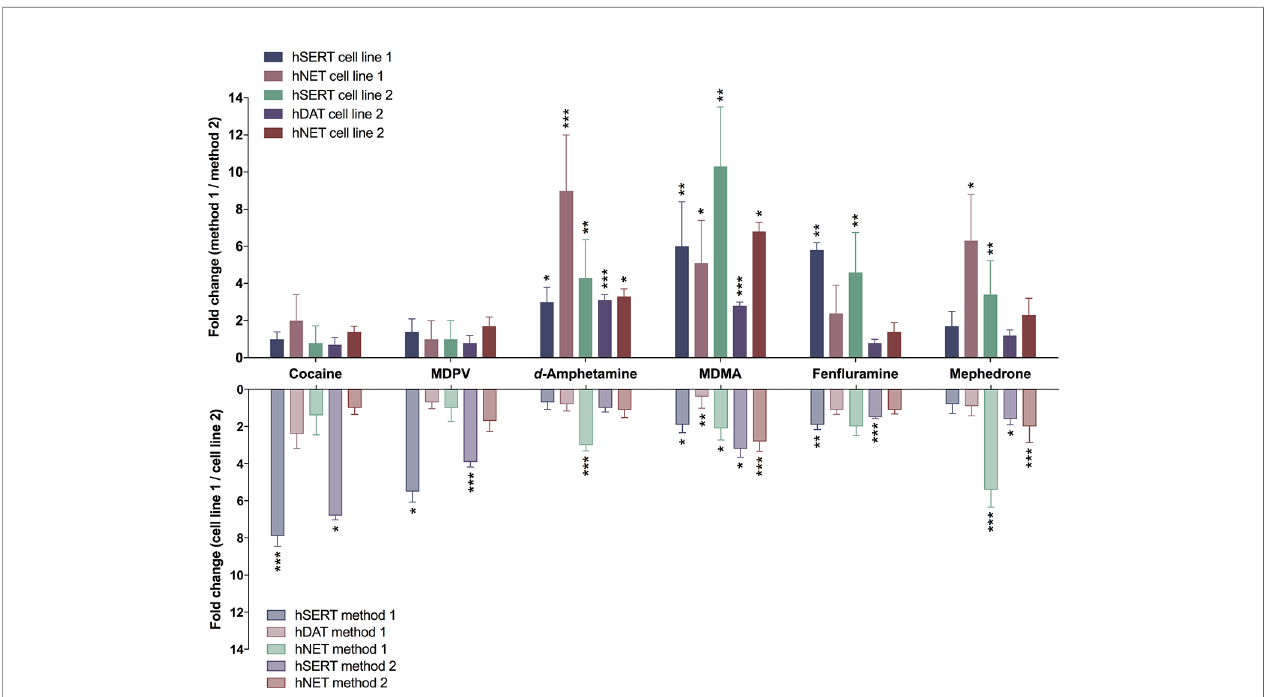
FIGURE 1 | Differences in transporter inhibition when assessed with different methods or in different cell lines. Bars represent fold-change of IC 50 values determined either with different methods (upper section) or with different cell lines [lower section; method 1 (adherent cells); method 2 (cells in suspension)]. Ratios were calculated from the IC 50 values present in Table 2 . Error bars represent error propagation from the division of two values. Asterisks indicate signi fi cant differences between two methods or two (cell lines used (*P < 0.05, **P < 0.01, ***P < 0.001; unpaired two-tailed t-test; Supplementary Tables 1 and 2